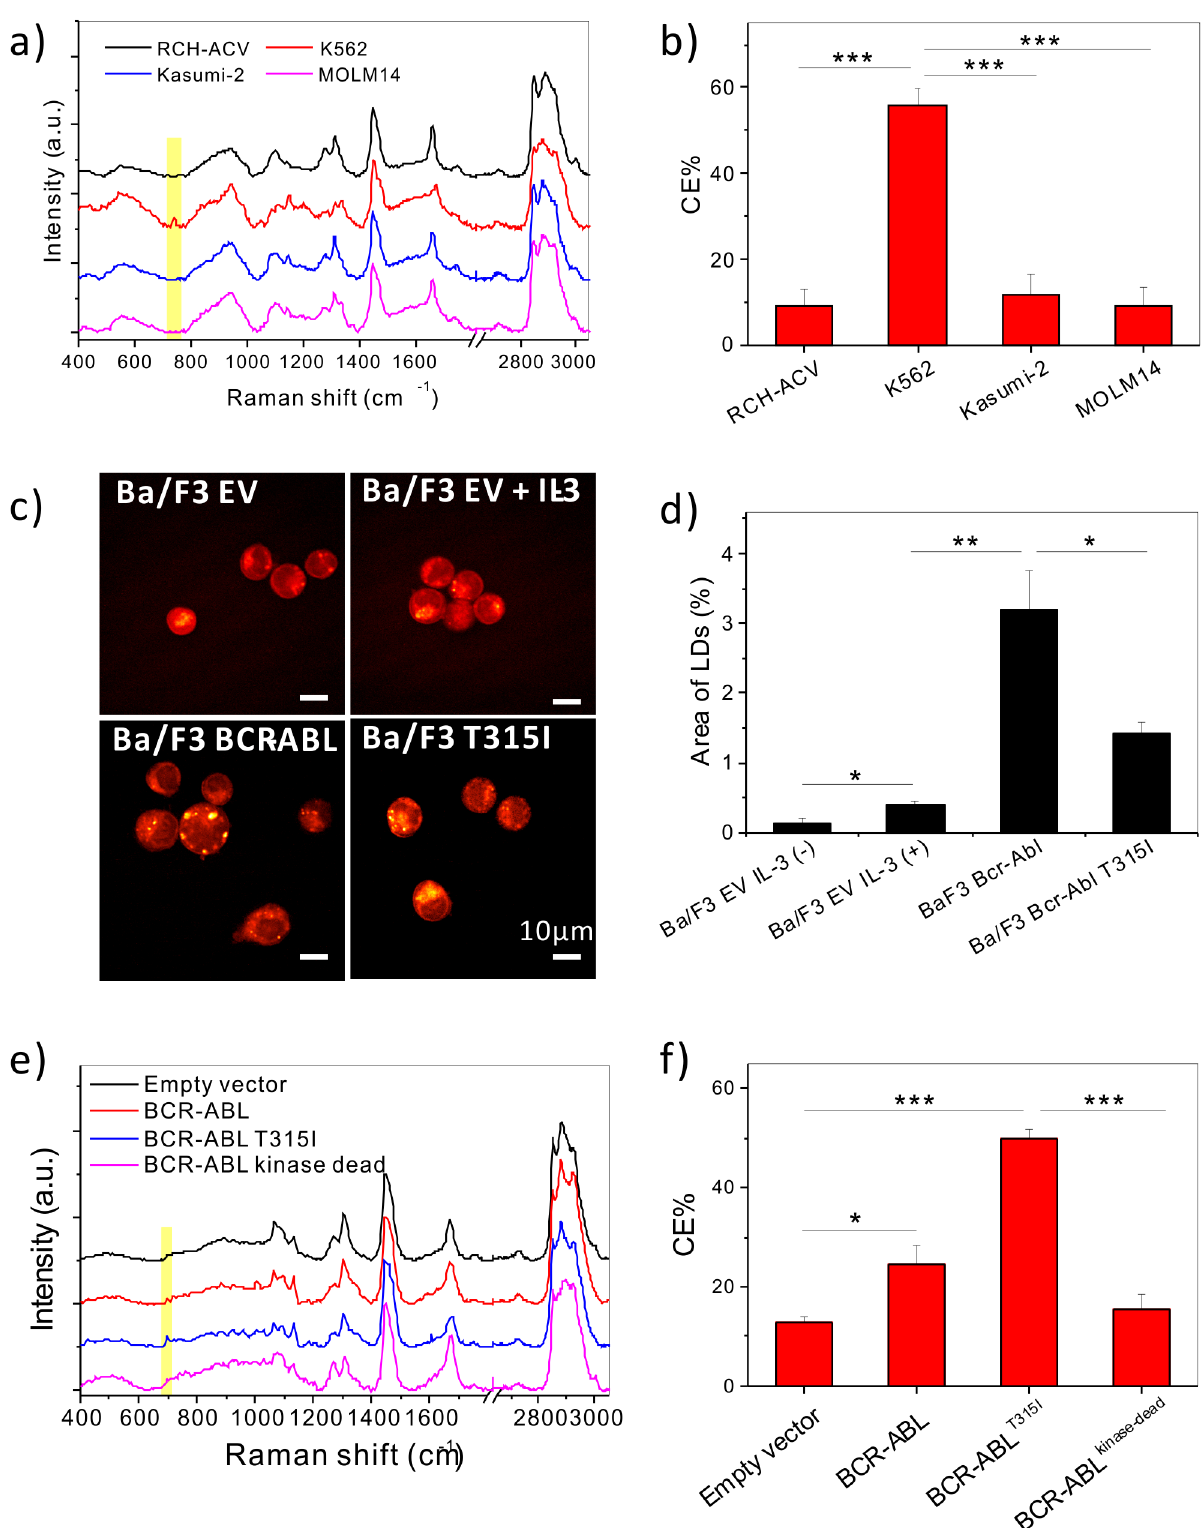
Fig 1. CE accumulation in CML. (a) Raman Spectra acquiredfrom LDs of four leukemiacell lines, includingRCH-ACV (ALL), K562 (CML), Kasumi-2 (ALL), and MOLM14 (AML).(b) Quantification of CE% out of total lipids in LDs in four leukemiacell lines. (c)